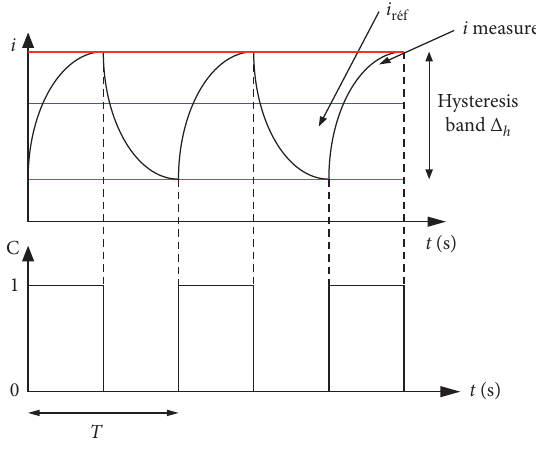
Figure 7: Principle of hysteresis regulator.